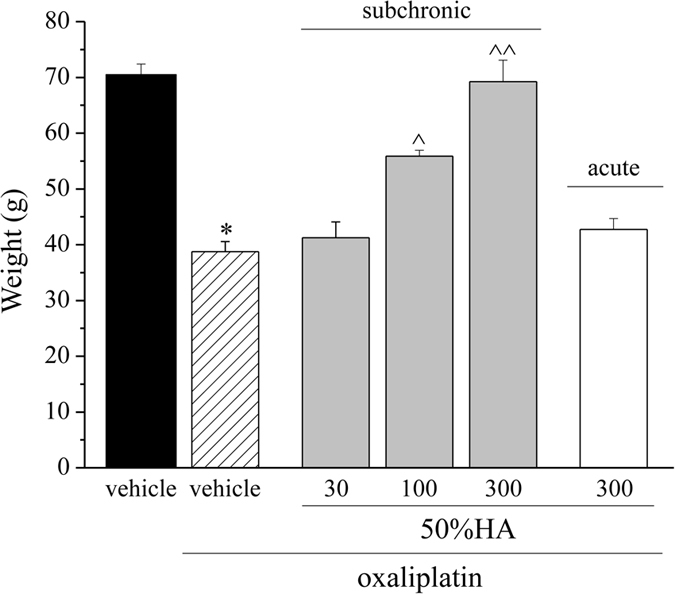
Behavioral measurements.Pain: subchronic and acute effect of 50%HA. On day 21, the pain reliever effect of 50%HA was evaluated by Paw pressure test. Oxaliplatin (2.4 mg kg−1) was injected daily i.p. for 3 weeks. (A) Increasing dosages (30, 100, 300 mg kg−1) of 50%HA were administered daily p.o., behavioural evaluations were performed 24 h after the last injection; (B) The acute effect of a single 50%HA administration (300 mg kg−1 p.o.) was evaluated 30 min after administration. Control animals were treated with vehicles. Each value represents the mean of 12 rats per group, performed in two different experimental sets. Values are represented as mean ± SEM. *P < 0.01 versus saline treatment; ^P < 0.05 and ^^P < 0.01 versus oxaliplatin treatment.